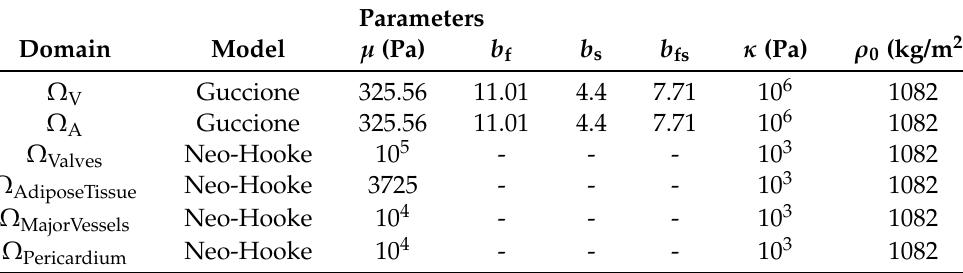
Table 3. Overview of passive mechanical parameters in W G , W NH for the whole heart